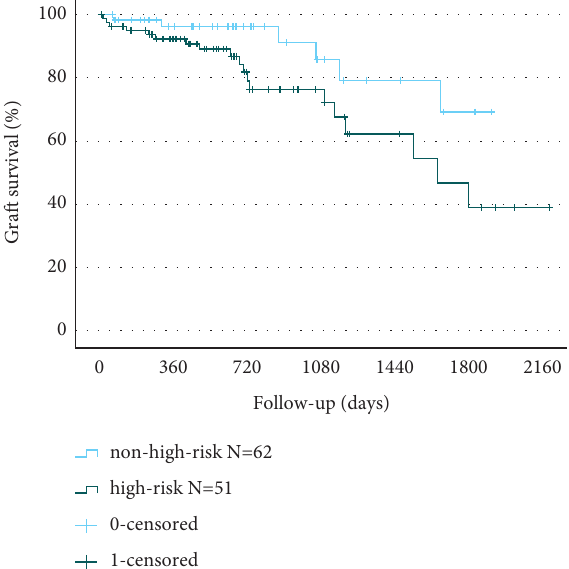
Figure 4: Corneal graft Kaplan-Meier survival curves in non-high- risk and high-risk patients ( p � 0 . 034, log-rank test).